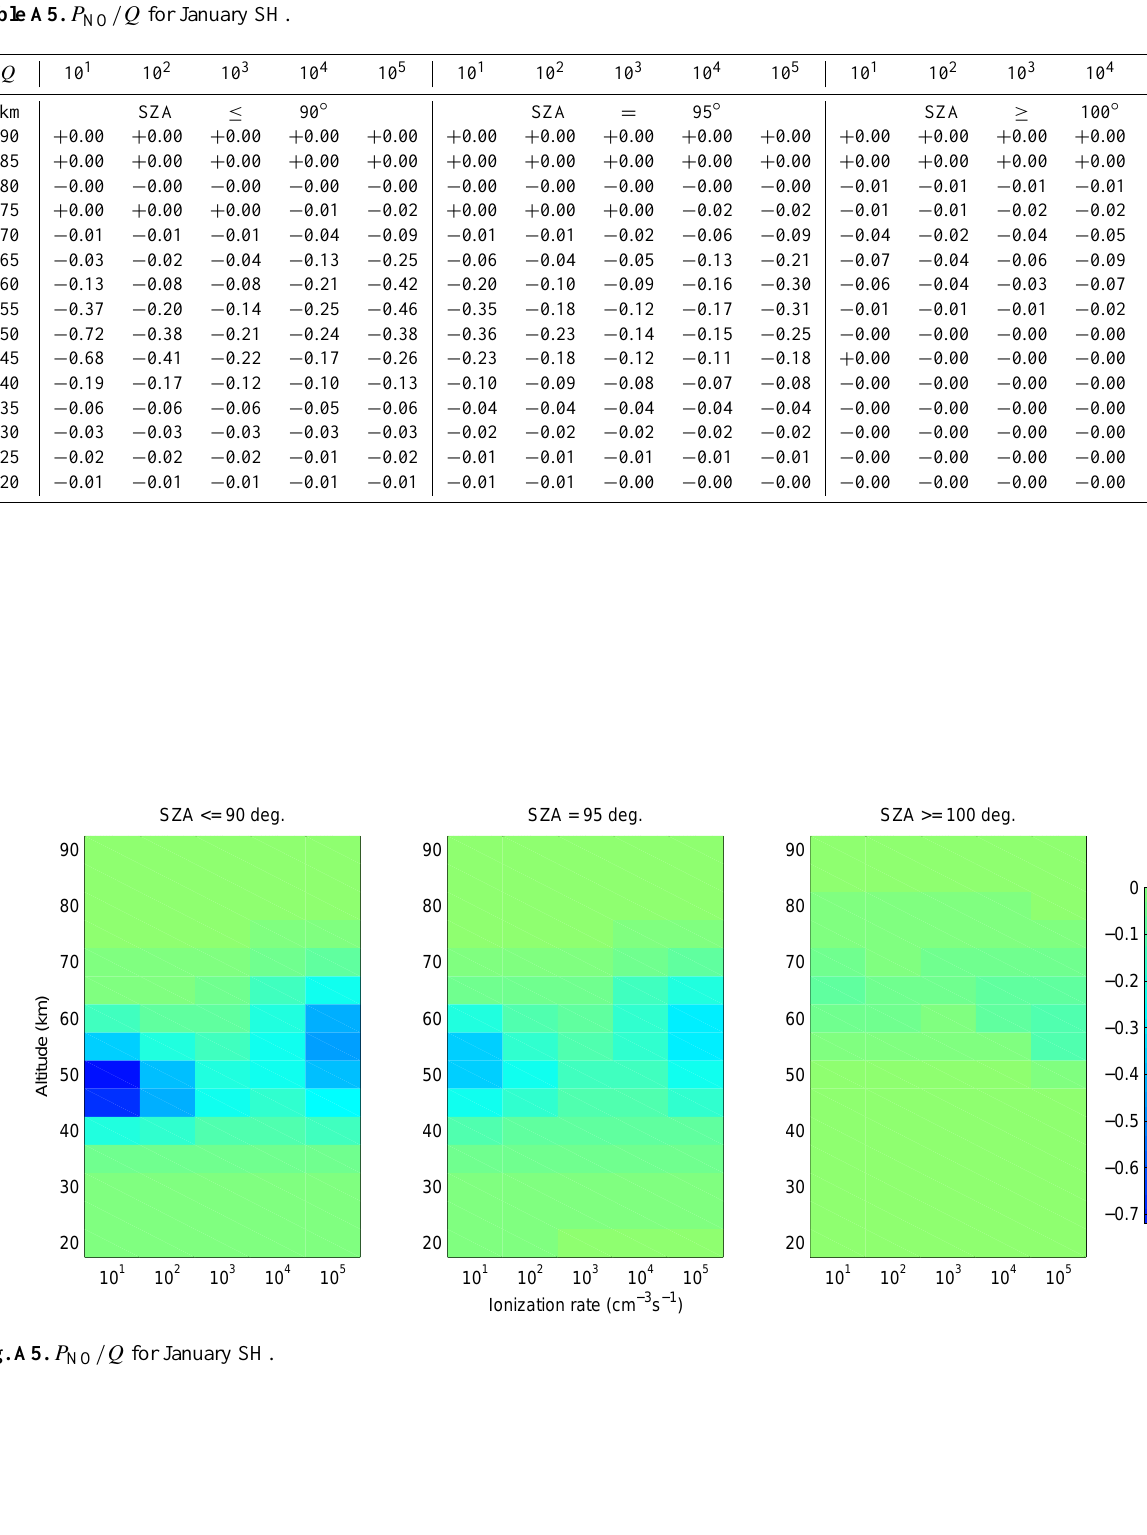
Table A5. P NO /Q for January SH.